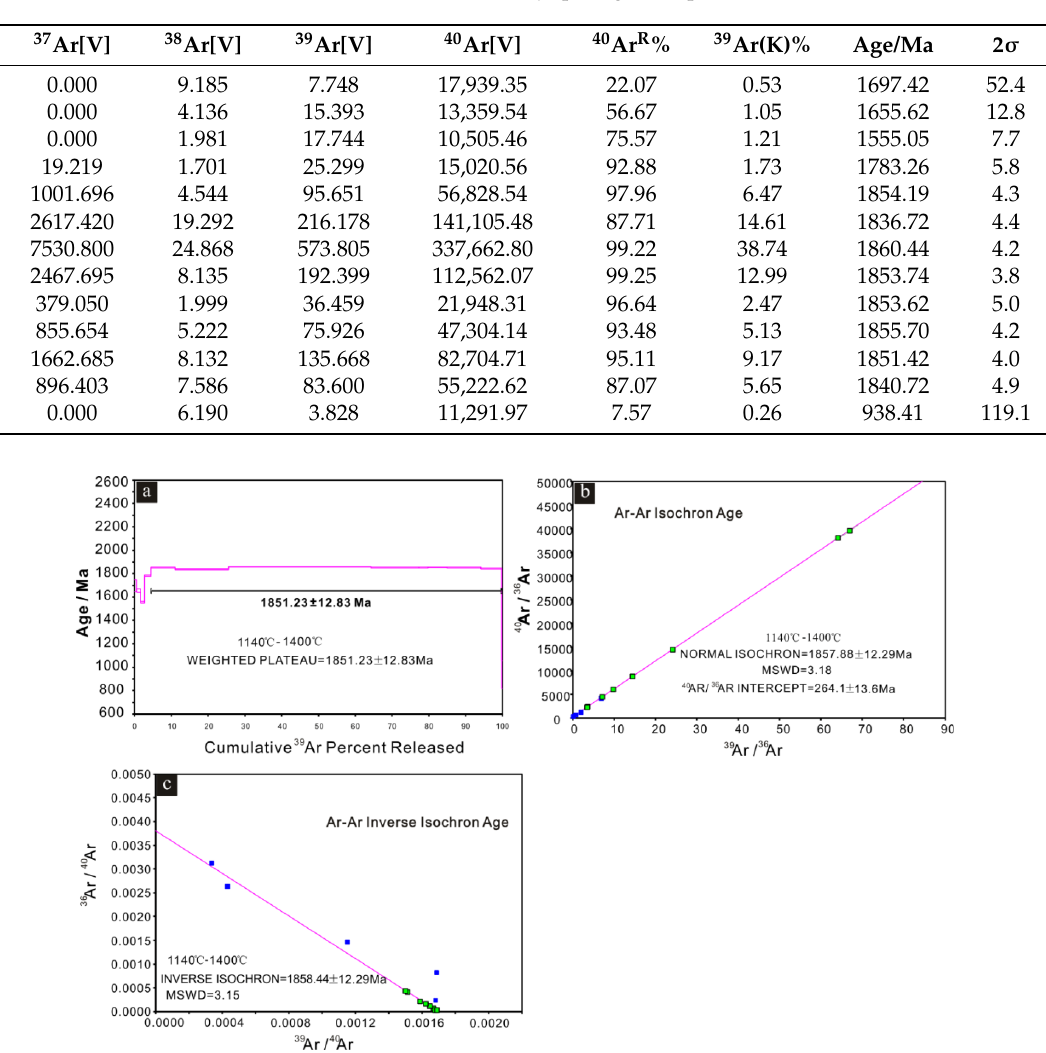
Table 1. 40 Ar- 39 Ar data of tremolite from the Lijiapuzi gold deposit.